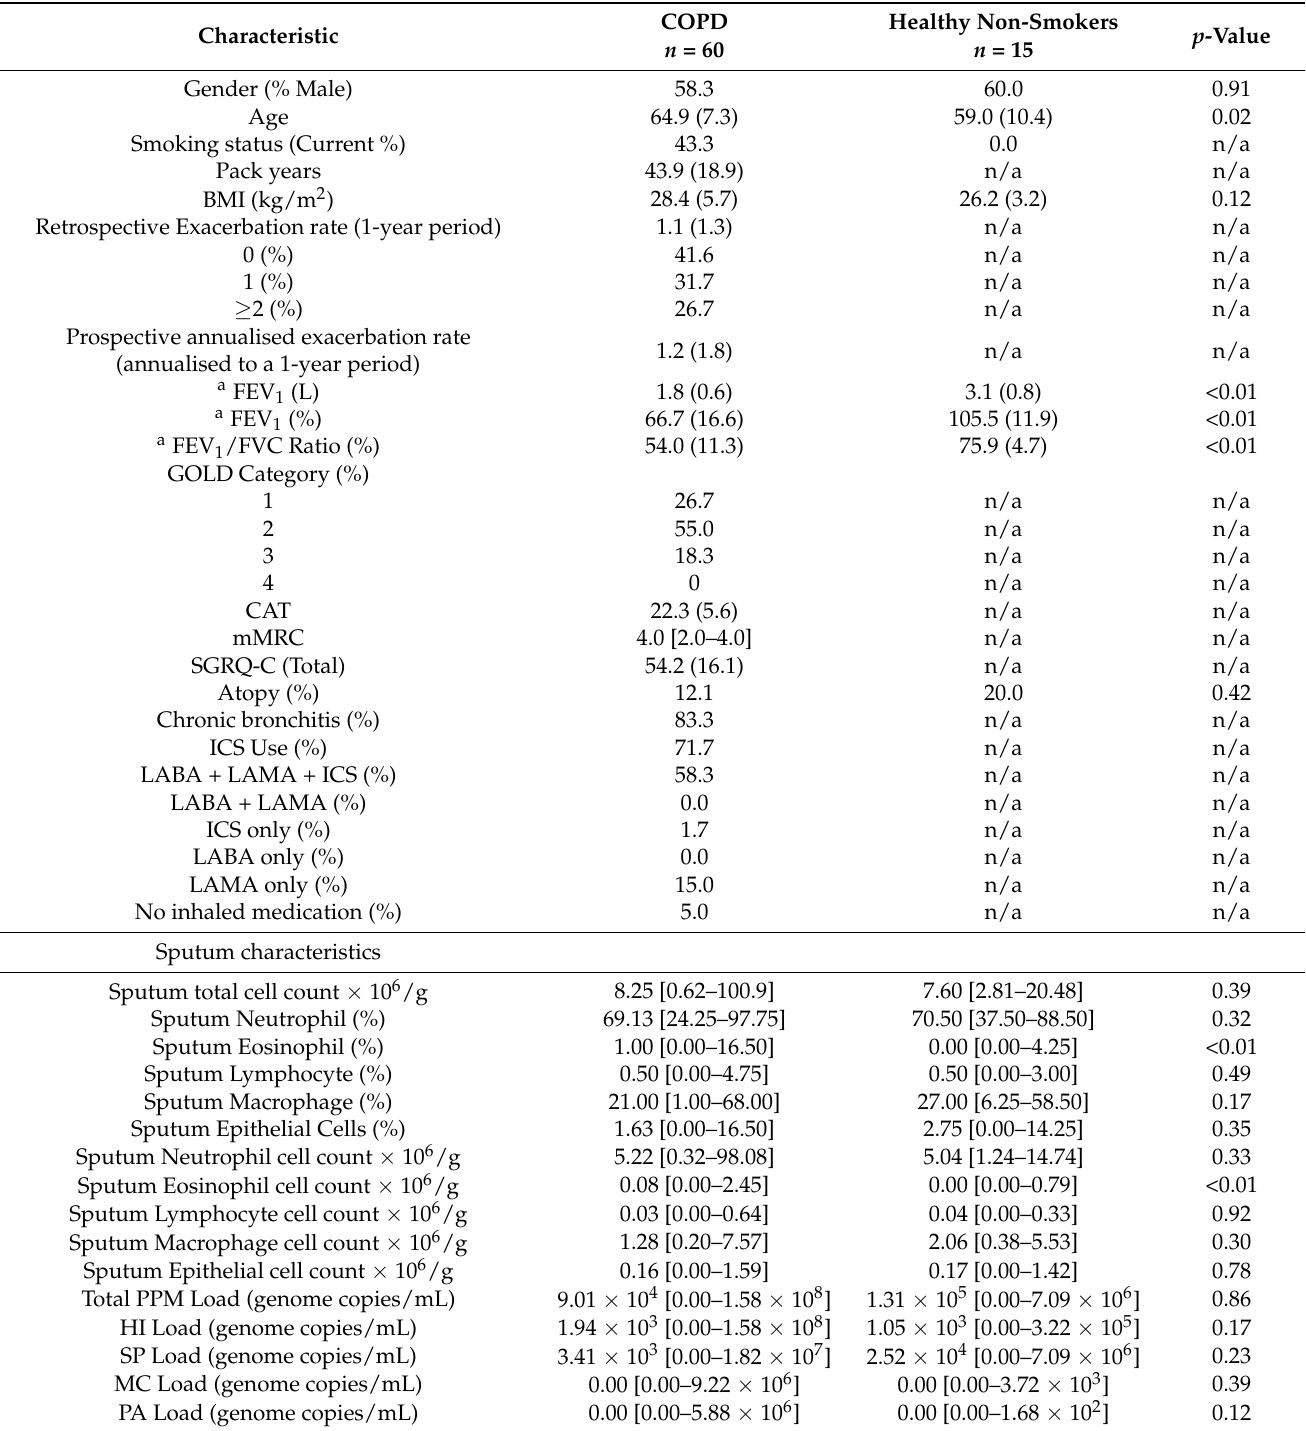
Table 1. Demographics for COPD subjects and healthy non-smoking controls. Summaries are presented as percentages, Mean (SD) or median [range] as appropriate ( n = 60 and 15, respectively